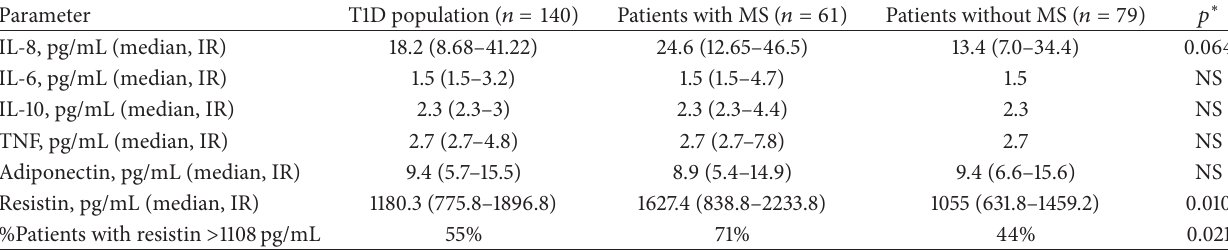
Table 2: Inflammatory profile in total T1D population and in patients with and without